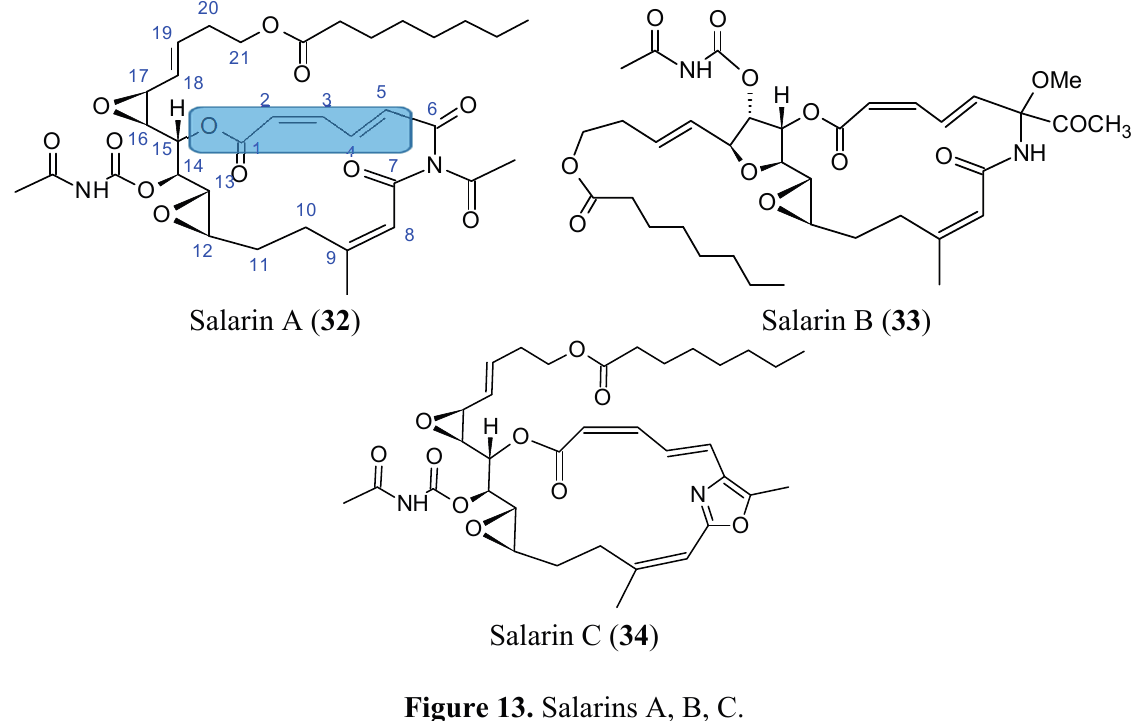
Figure 13. Salarins A, B, C.